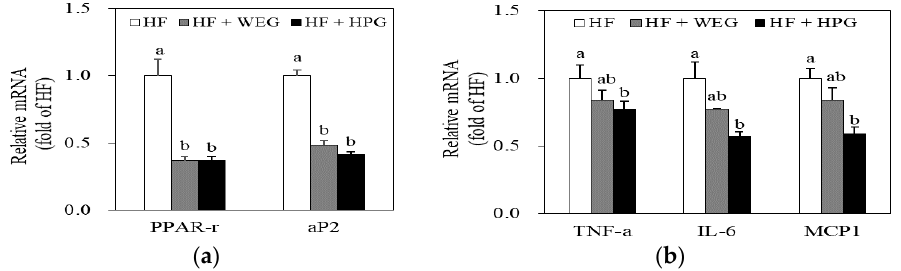
Figure 5. Effects of WEG and HPG on mRNA expression of genes related to adipogenesis and pro-inflammatory cytokines in white adipose tissue (WAT). The mRNA levels of ( a ) adipogenesis and ( b ) pro-inflammatory cytokines were measured using real-time qPCR. Values represent fold changes compared to the control. Values are expressed as mean ± SEM ( n = 9/group). a,b Mean values with unlike superscript letters are statistically different at p < 0.05. HF: high fat; WEG: hot water extract of ginger; HPG: high-hydrostatic pressure extract of ginger; PPAR- γ : peroxisome proliferator-activated receptor- γ ; aP2: adipocyte protein 2; TNF- α : tumor necrosis factor- α ; IL-6: interleukin-6; MCP1: monocyte chemoattractant protein-1.